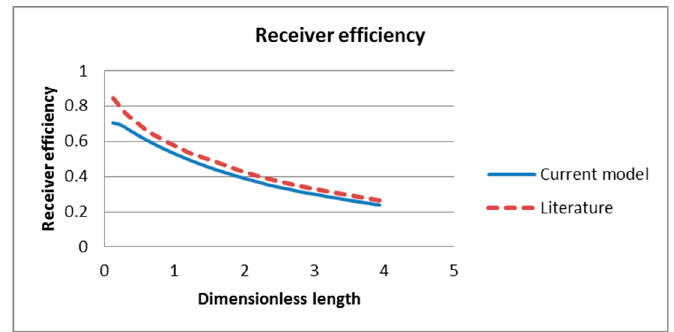
Figure 6. Comparison of receiver efficiency of current model and A. Veeraragavan’s model [29].